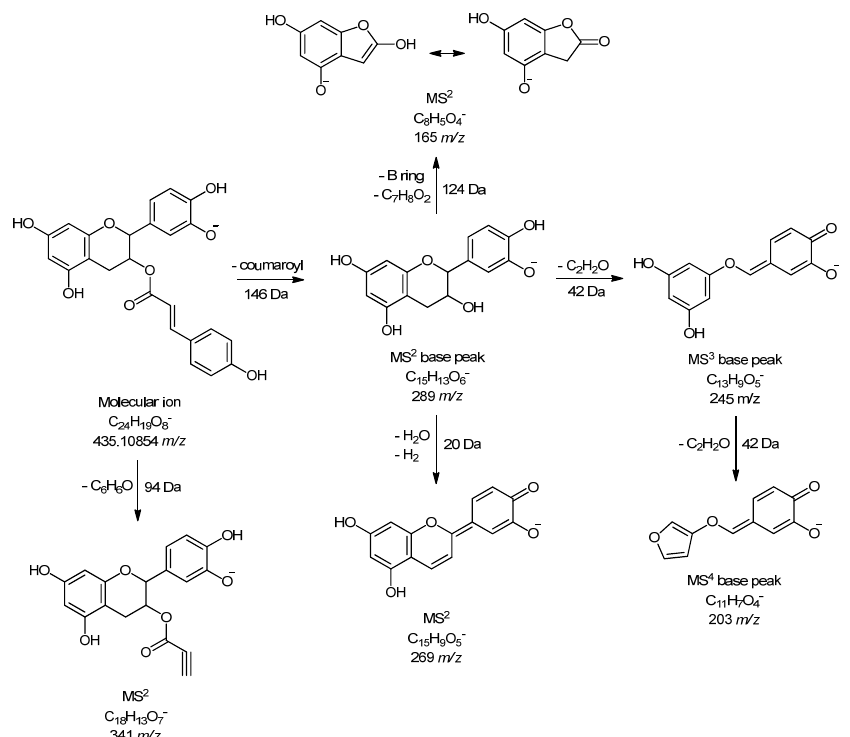
Figure 1. Fragmentation pathway of (Epi)catechin 3- O -coumarate ( 65 ) in negative ionization mode.